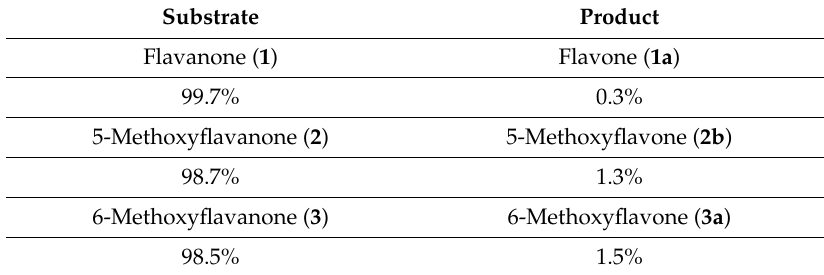
Table 3. Percentage of substrates and biotransformation products in P. coccineus callus cultures on solid